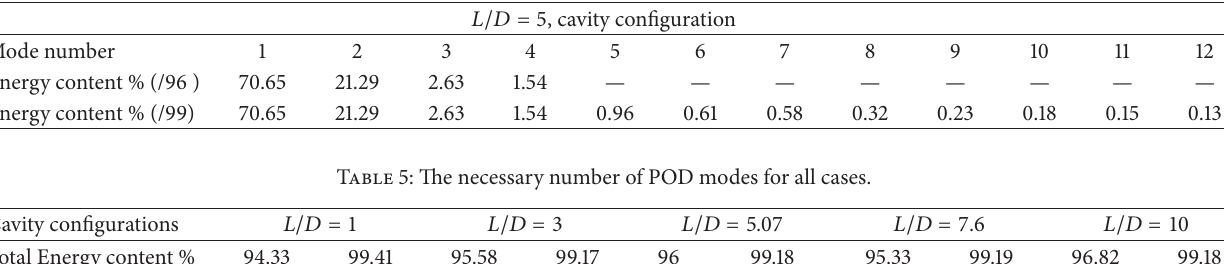
Table 4: 𝐿/𝐷 = 5 cavity, POD modes energy contents.